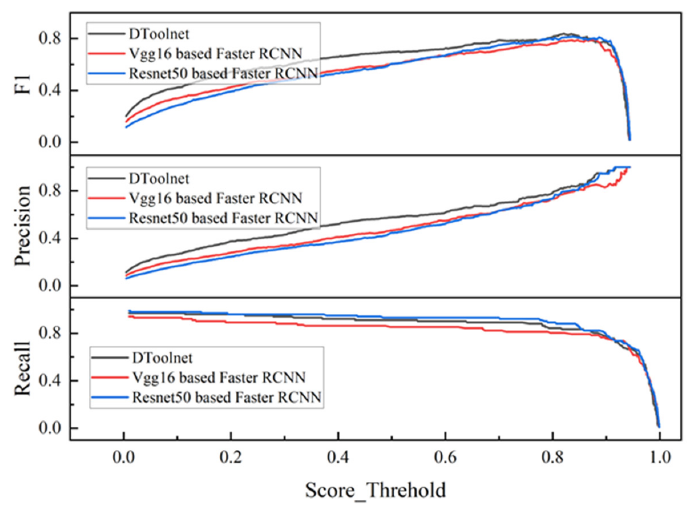
Figure 15. The performance of different networks on the test set.